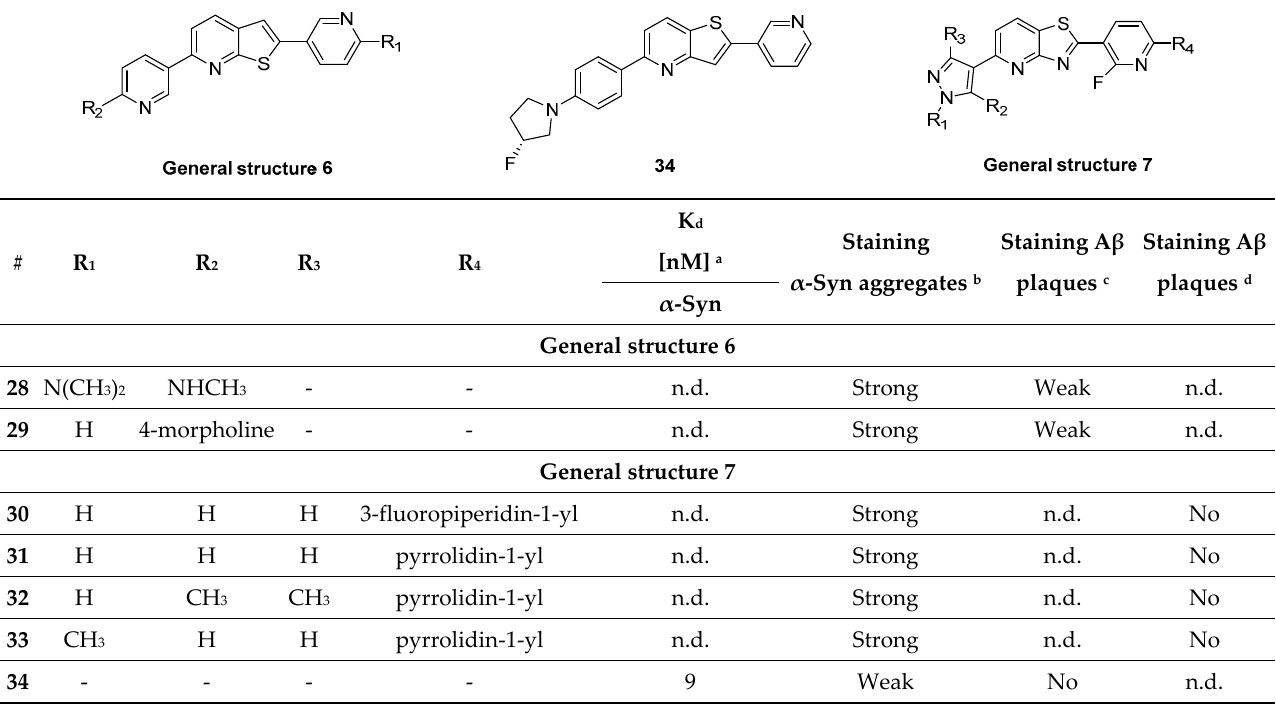
Figure 16. Chemical structures of thienopyridine, thiazolo pyridine derivatives with key properties. Chemical structures of compounds 28-34 and general structures with key binding properties. a Affinity toward α -syn fibrils aggregates determined by backscattering interferometry on PD brain homogenates. b Staining of α -syn aggregates on PD sections. c Staining of A β plaques on AD sections. d Staining of A β plaques on PD sections with mixed pathology. n.d.: not determined. Literature source [113].